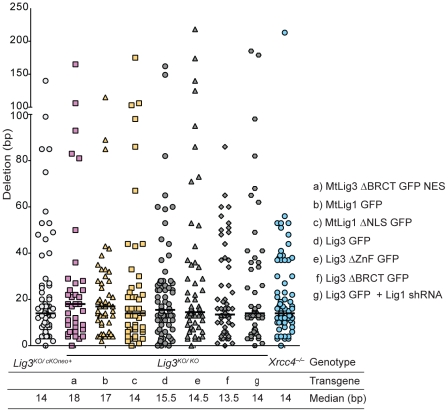
Deletion lengths for der(6) breakpoint junctions.Deletion lengths for the indicated genotypes do not differ significantly from each other. Each value represents the combined deletion from both ends of an individual junction. The median deletion length for each genotype is indicated by a bar on the graph and the value is given below the graph.